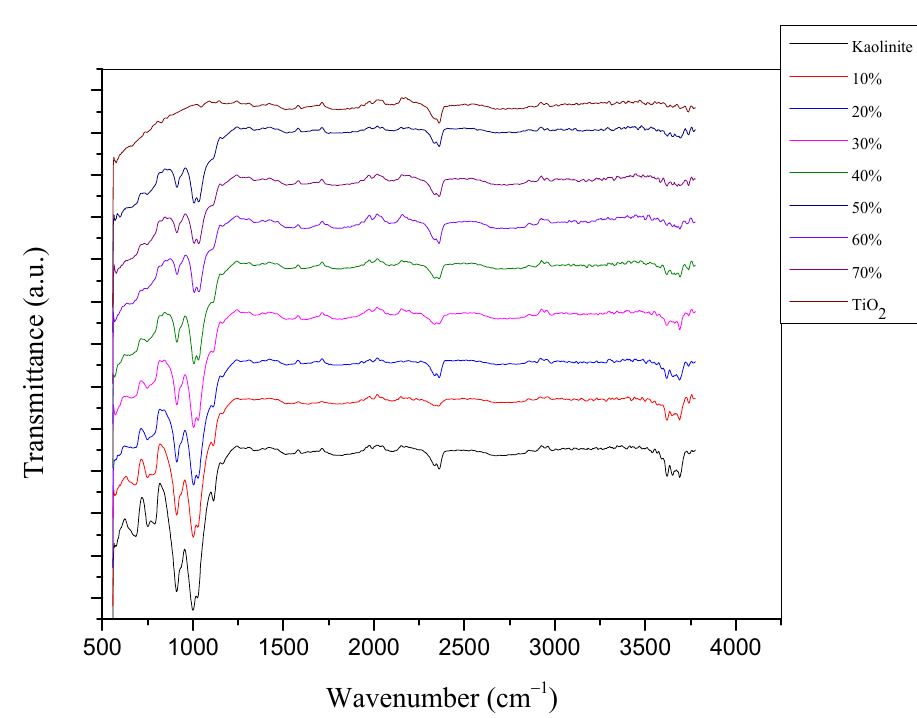
Figure 3. FTIR spectra of kaolinite, X% (X = 10, 20, 30, 40, 50, 60, 70): percentage of TiO 2 in TiO 2 –JK NC.